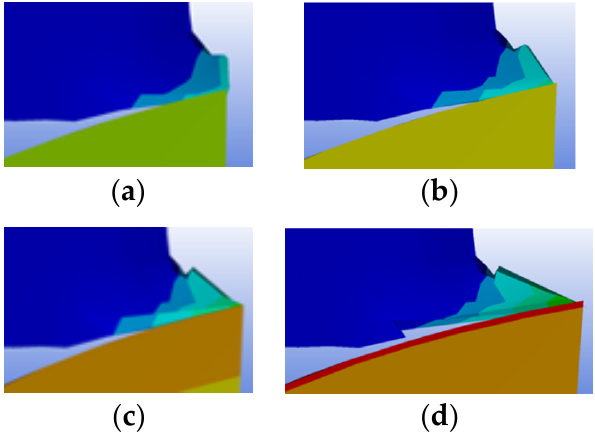
Figure 5. Cutting Tool Engagement over 4 discrete time periods—( a ) at 1.025 × 10 − 4 , ( b ) 2.05 × 10 − 4 , ( c ) 3.075 × 10 − 4 , and ( d ) 4.1 × 10 − 4 .